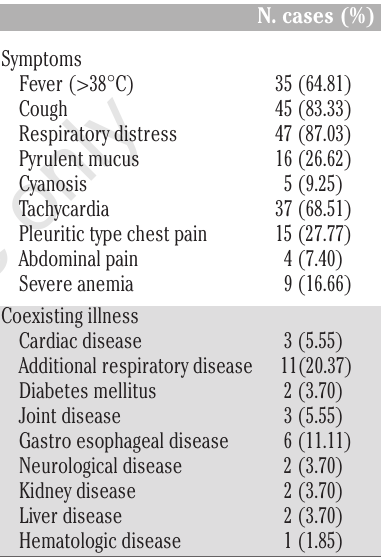
Table 2. Symptoms of the cases and accompanying diseases in the cases. N. cases